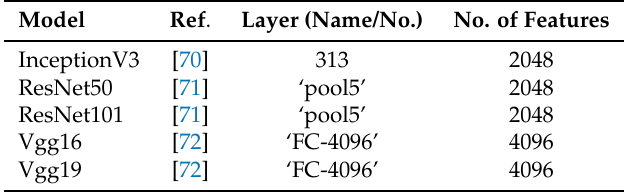
Table 1. Round-up table of the pre-trained convolutional models considered in the